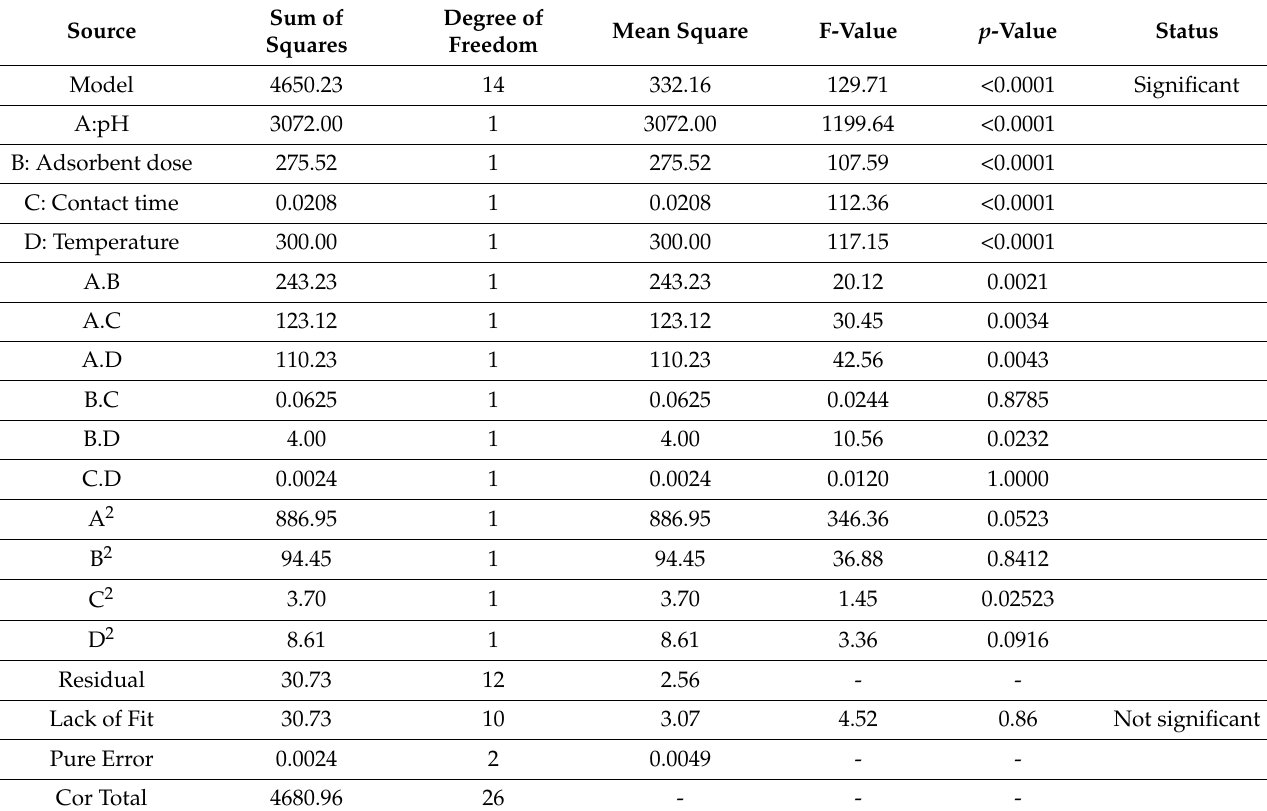
Table 5. Analyses of variance analysis of Pb(II)